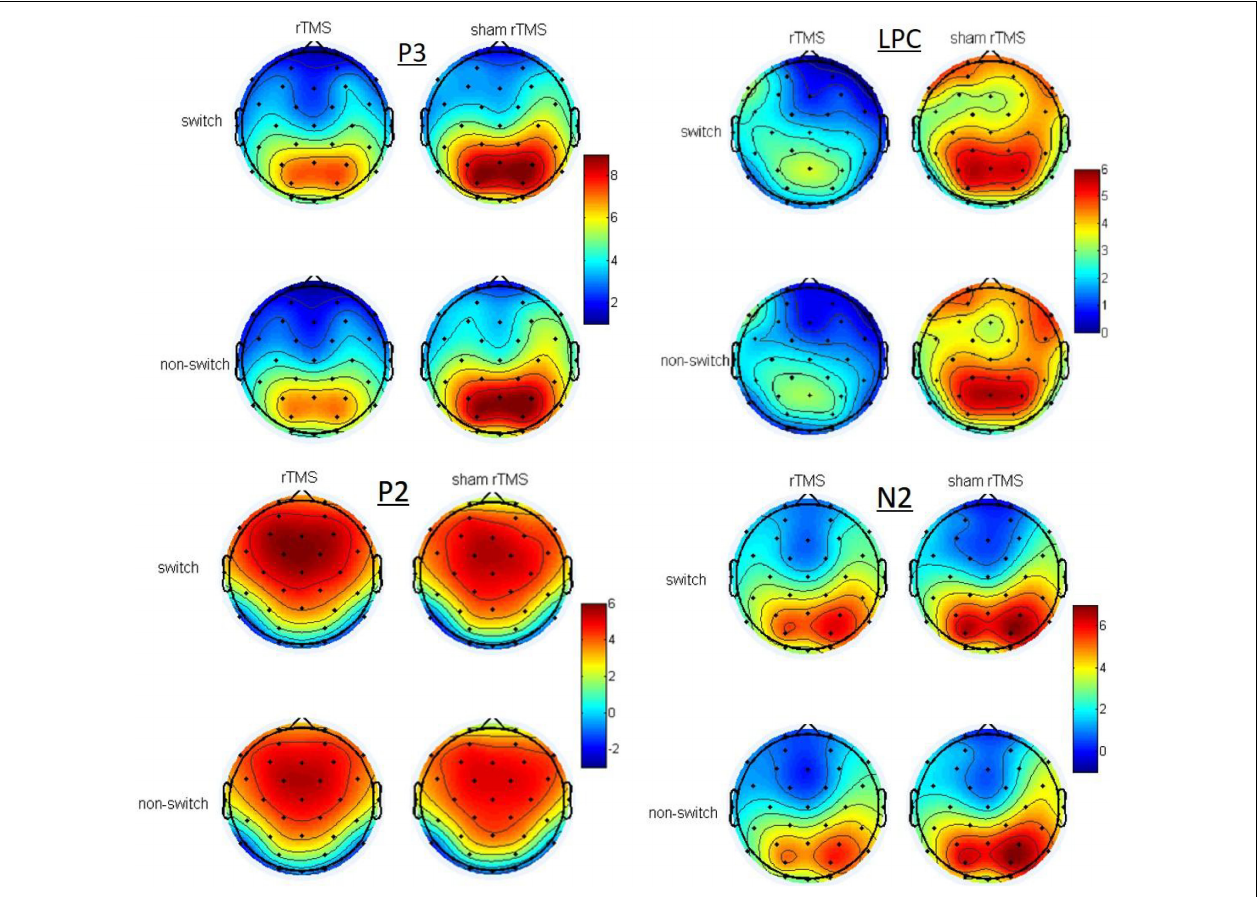
FIGURE 3 | Topographic maps of the voltage distribution of P2, N2, P3, and LPC to switch and non-switch conditions for 1 Hz rTMS and sham rTMS stimulations at post-stimulation. which revealed significant decreased LPC amplitude in rTMS (2.51 ± 0.398 µ V) in contrast to sham rTMS (3.829 ± 0.622 µ